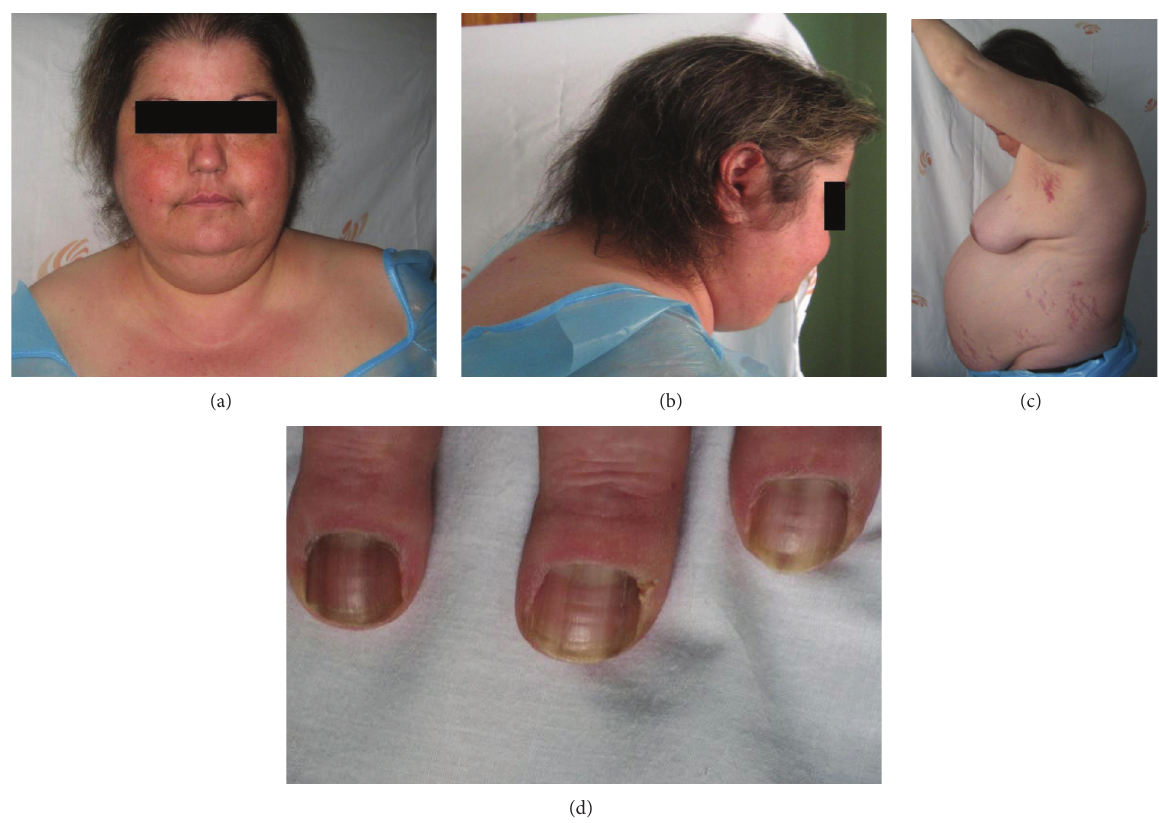
Figure 1: Patient